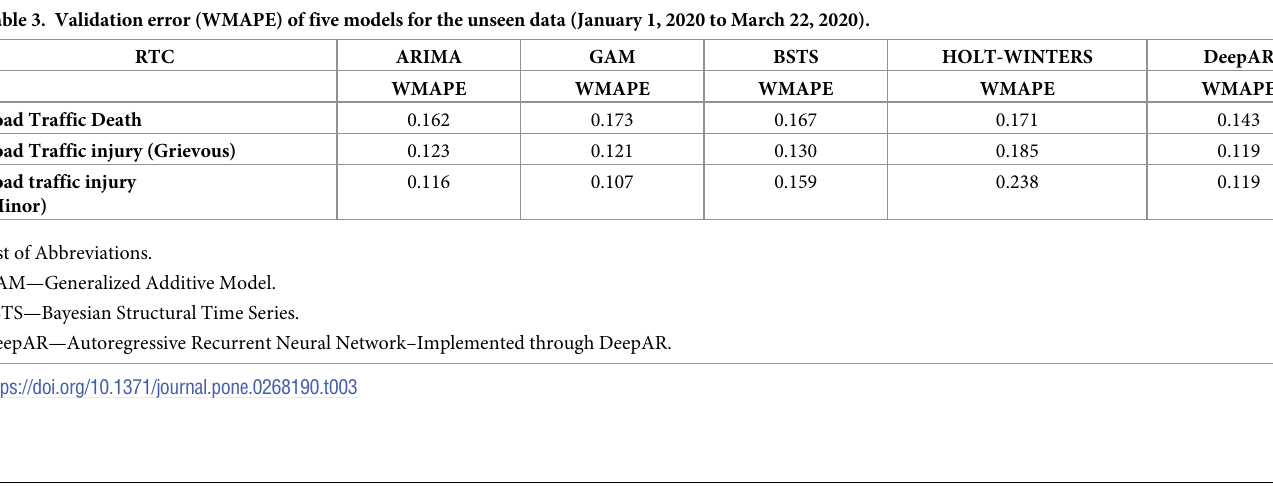
TN as shown in Table 4. In general, one could say that the pattern of decline in RTD during CL and PL phases in wave one and wave two are very similar (Fig 4). When the model predicted the unseen test data during the validation period (pre-lockdown period), the forecasted range of daily counts of RTD is almost the same as the actual incidence of the events. The notable difference is in the post lockdown phases. When the curbs were removed during Post-L-2020, there was no difference in the actual and predicted number of RTD, and the decline was only partial, at 8.55% (cliff delta of -0.165). However, after the